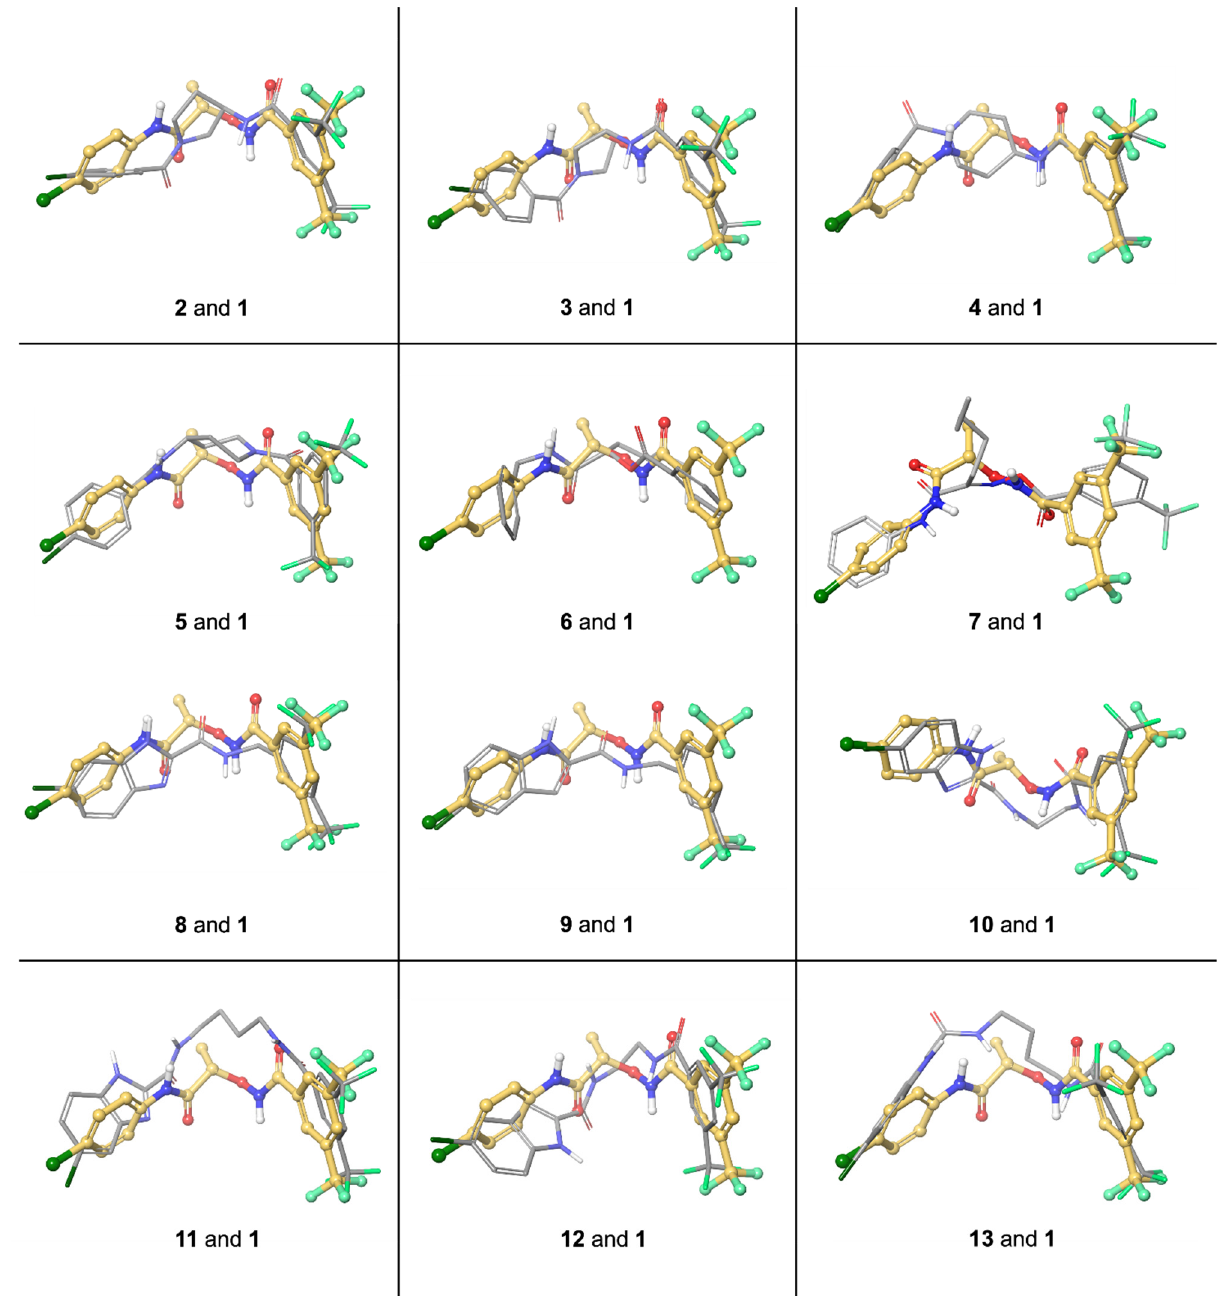
Figure 4. Best alignment of compounds 2 – 13 on the lowest energy minimum conformation of 1 (Cluster 4), as obtained with the Phase module.